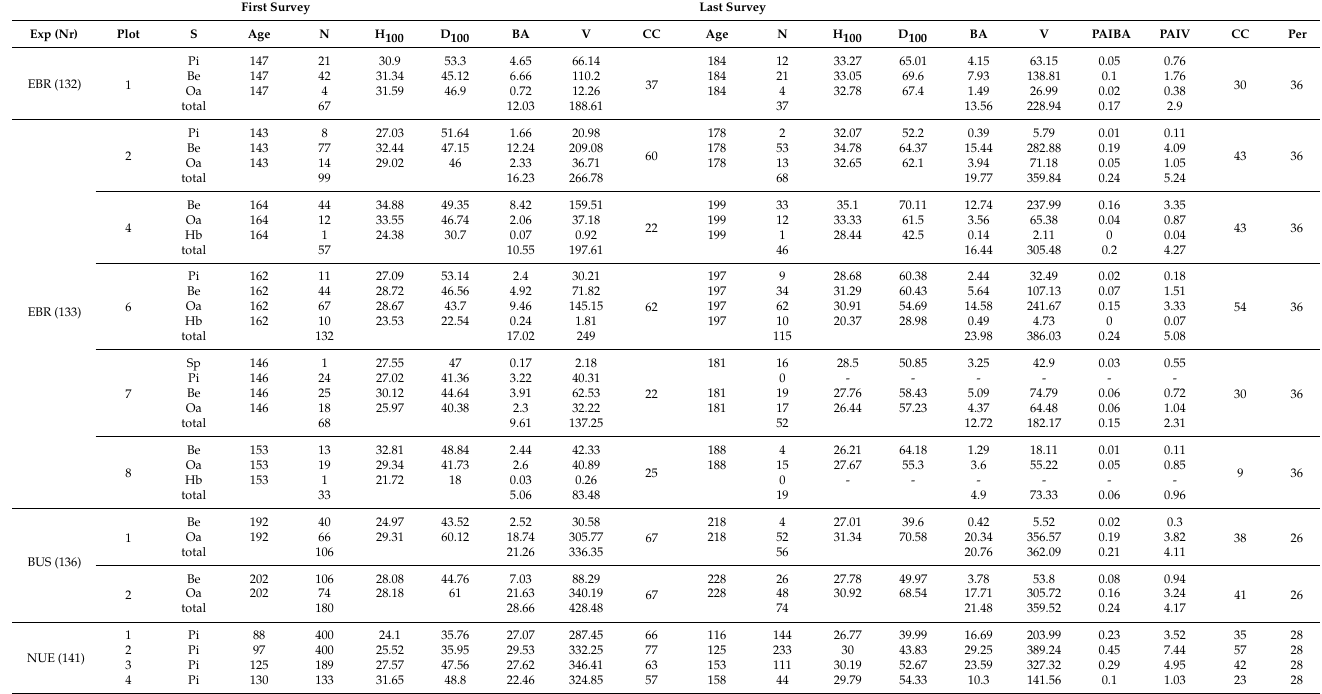
Table 2. Yield data of the main stand for the first and latest survey; S—tree species; Age—stand age [yrs]; N—number of trees [n ha − 1 ]; H 100 —dominant height [m]; D 100 —dominant diameter